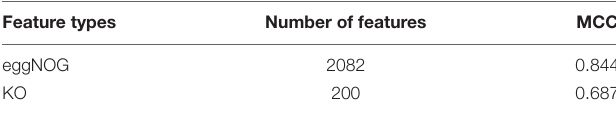
TABLE 1 | MCC performance of classifiers with different features. Figure 4 . Similar to the optimal SVM classifier with eggNOG annotations, the SP was still not very high, whereas other measurements were satisfied. It is indicated that such classifier also provided good